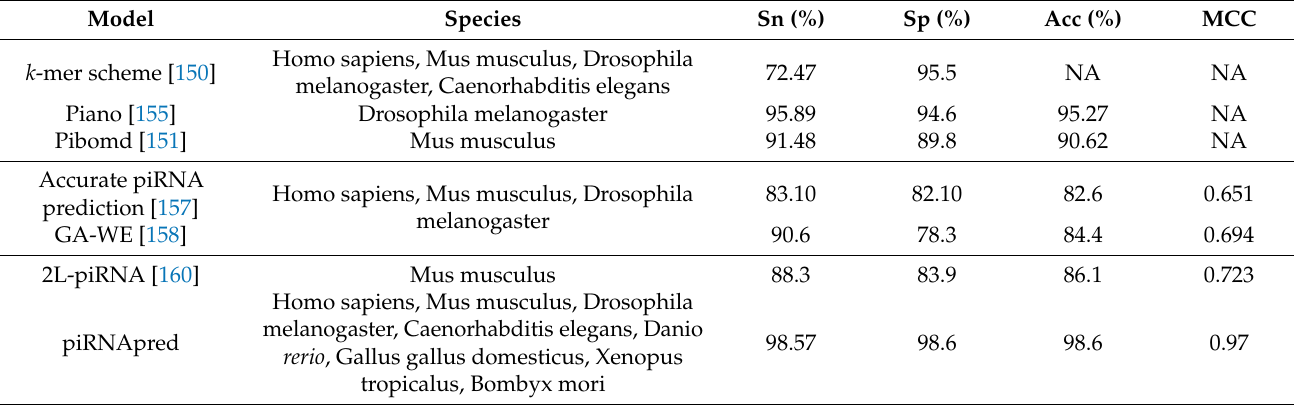
Table 8. Summary of the performance of piRNAPred and previously published methods on piRNA datasets from 8 species. Model k -mer scheme